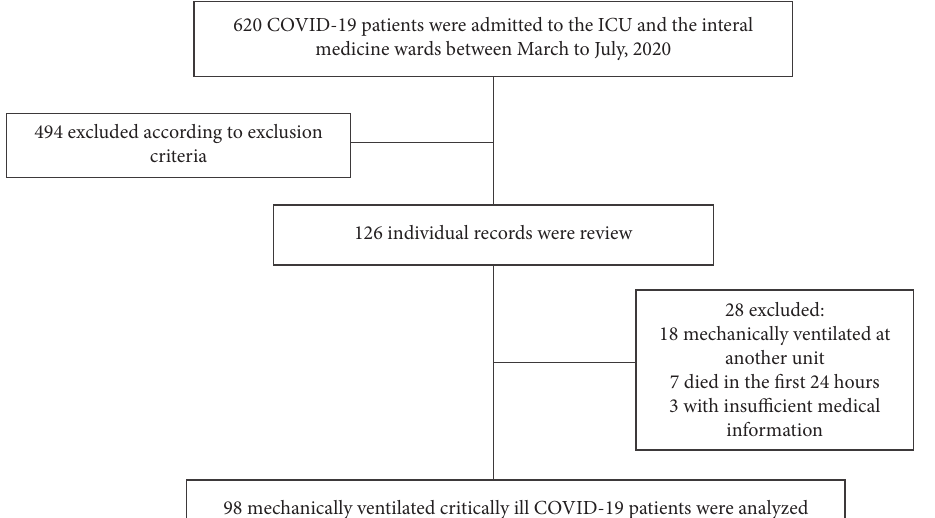
Figure 1: Flow diagram of the